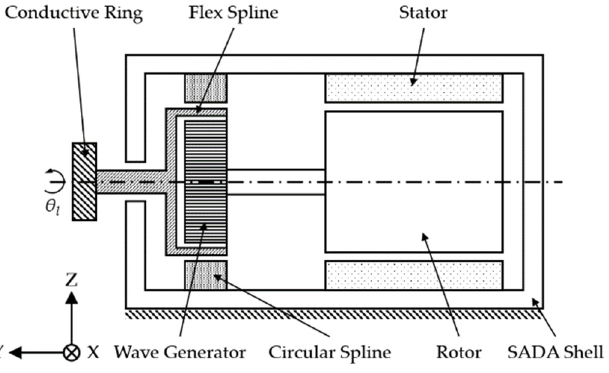
Figure 2. Structure sketch of the SADA. It is assumed that (1) the transmission efficiency of the harmonic reducer is 100%; (2) the stepper motor rotor, the wave generator, and the flexible spline of the harmonic reducer only have the rotational degree of freedom around the rotation